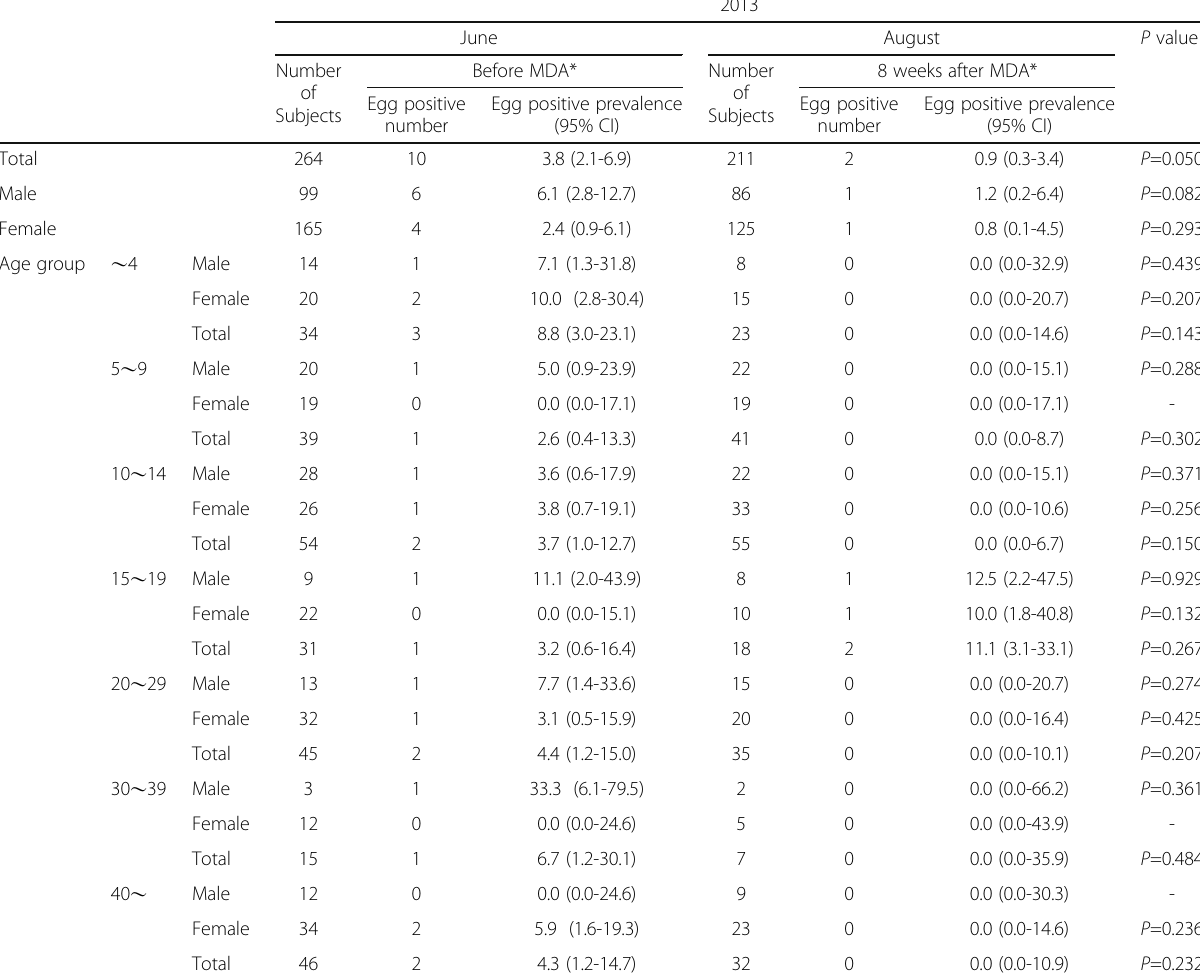
Table 3 Results of urine filtering examination